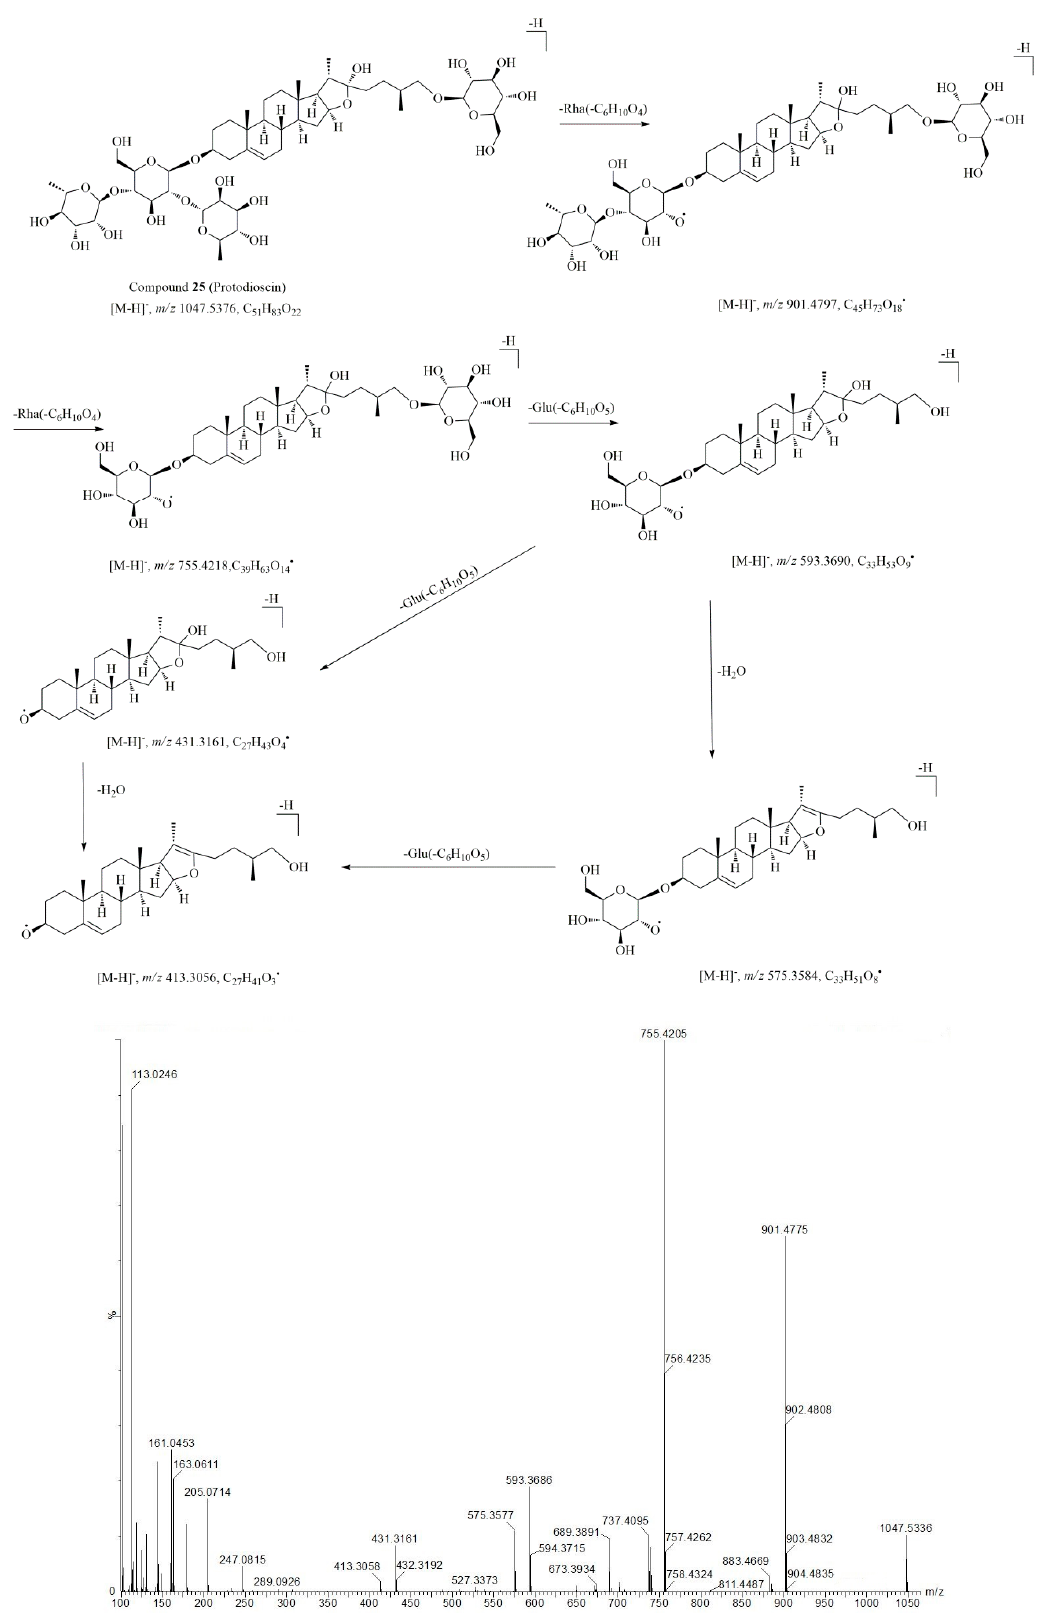
Figure 2. The hypothesized fragmentation pathway and MS/MS spectrum of compound 25 .